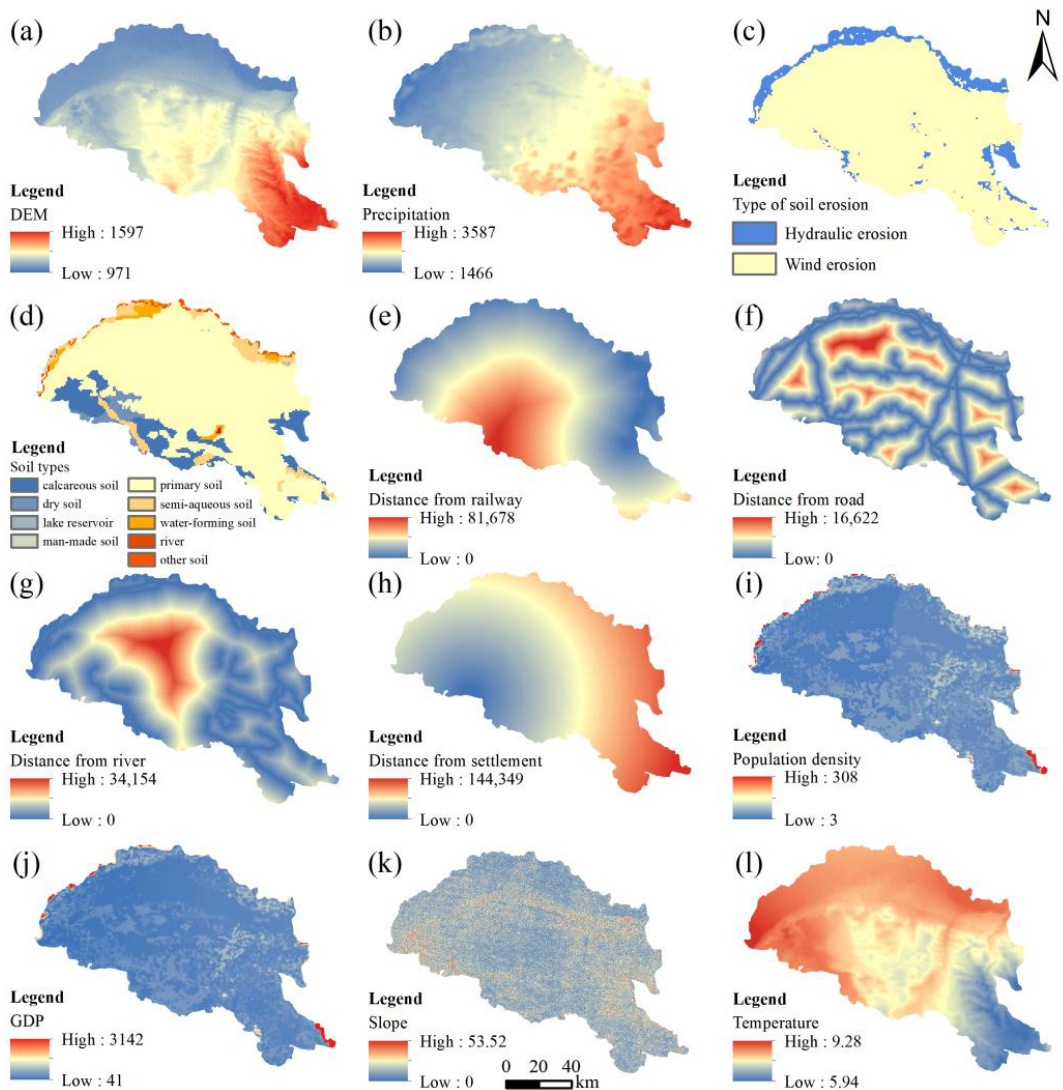
Figure 2. Land-use driving factors. ( a ) DEM. ( b ) Precipitation. ( c ) Type of soil erosion. ( d ) Soil types. ( e ) Distance from railway. ( f ) Distance from road. ( g ) Distance from river. ( h ) Distance from settlement. ( i ) Population density. ( j ) GDP. ( k ) Slope. ( l ) Temperature.